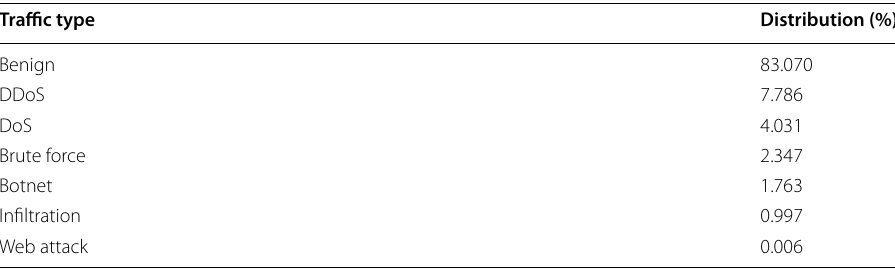
Table 1 CSE-CIC-IDS2018 traffic